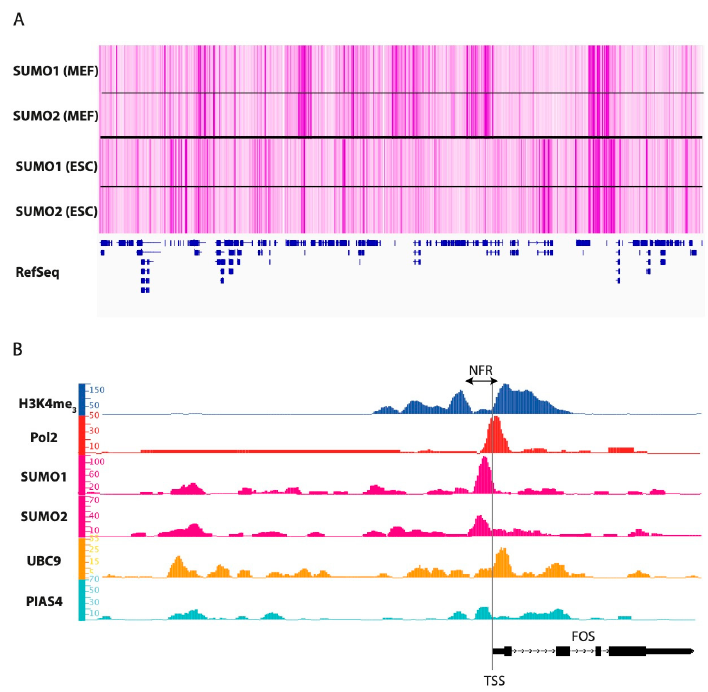
Figure 2. SUMO distribution on chromatin. ( A ) SUMO distribution on chromatin. SUMO is found at many discrete sites in ChIP-seq experiments, as illustrated here for a portion of mouse chromosome 9 (GSE99009). However, whereas signal distribution can be very similar between SUMO-1 and SUMO-2/3 in the same cellular context, it can vary to a great extent from one to another cell type, as shown here between mouse embryo fibroblasts (MEF) and mouse embryonic stem cells (ESC) [137]. SUMOylation patterns can also change in response to different signaling cues (see Text). ( B ) SUMO at a transcriptionally active gene. The c-Fos gene is taken as an illustrative example using ChIP-Seq data obtained in human primary fibroblasts (GSE42213) [175]. The transcriptional start site (TSS) lies in a nucleosome free region (NFR) around which Histone 3 is marked by trimethylation of its lysine 4, H3K4me3 usually being associated with transcriptional activity. High Pol II signal just downstream of the TSS is indicative of c-Fos as a paused gene (see Text for details). SUMO-1 and SUMO-2 signals peak in the NFR just upstream of the TSS but SUMO signals are also observed at discrete locations all over the locus. The SUMO E2 (Ubc9) and a SUMO E3 (PIAS4) are also found all over the locus. However, colocalization of SUMO, Ubc9 and PIAS4 is not strict, as found at many other places on the genome.